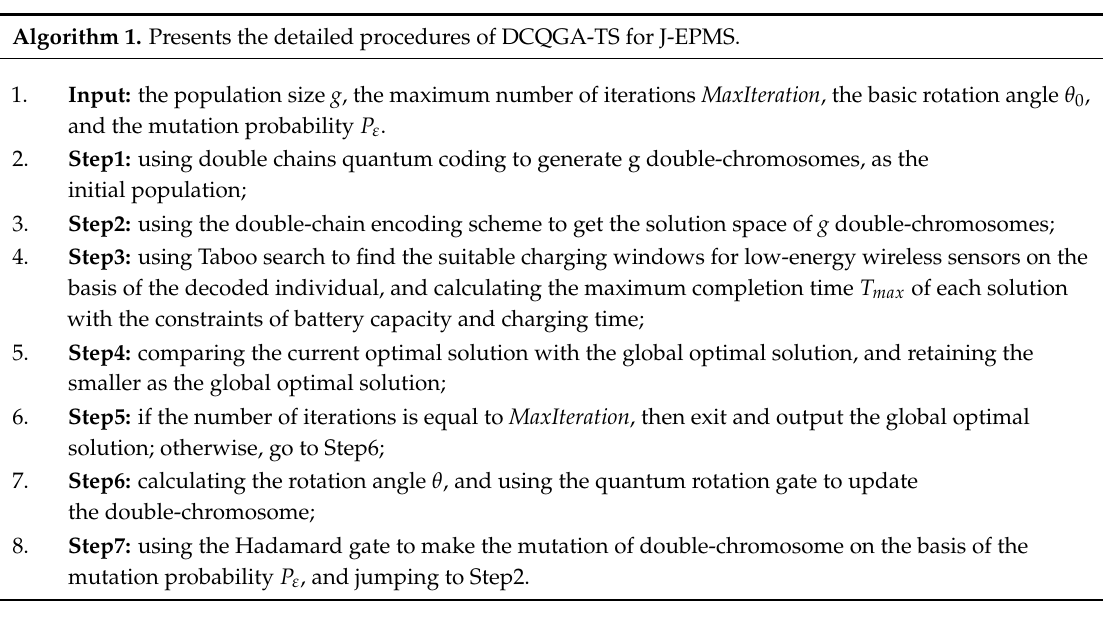
Algorithm 1. Presents the detailed procedures of DCQGA-TS for